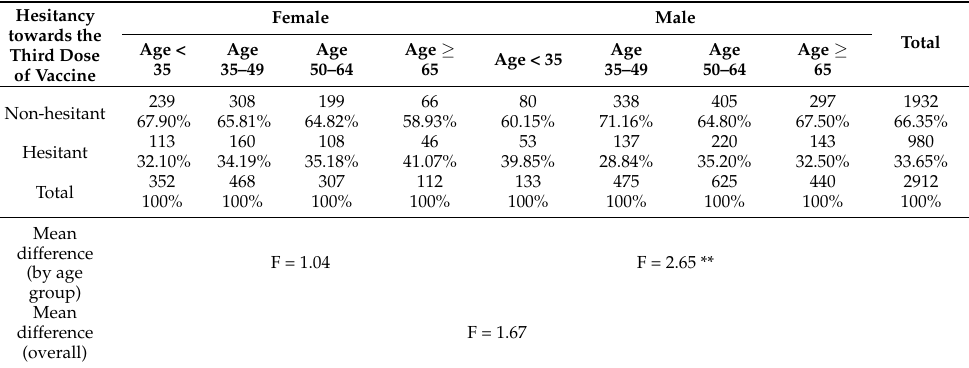
Table 3. Hesitancy towards the third dose of COVID-19 vaccine, stratified by gender and age.